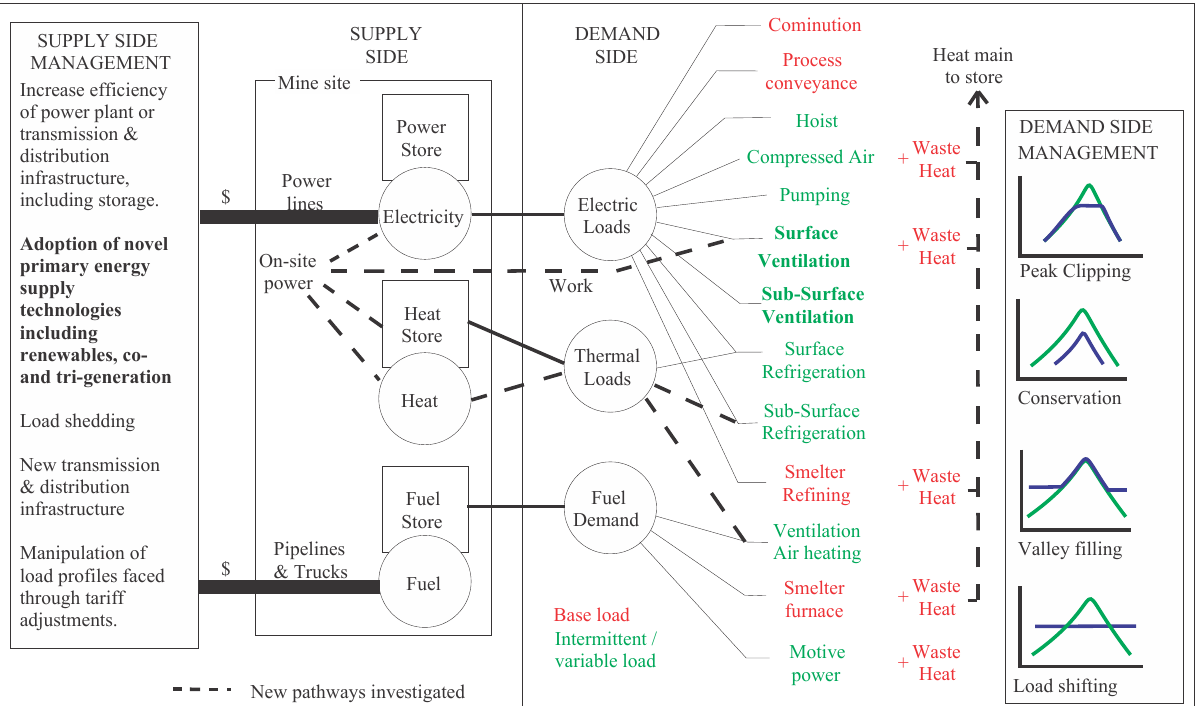
Figure 1. Preliminary framework for energy management activities in an underground mine